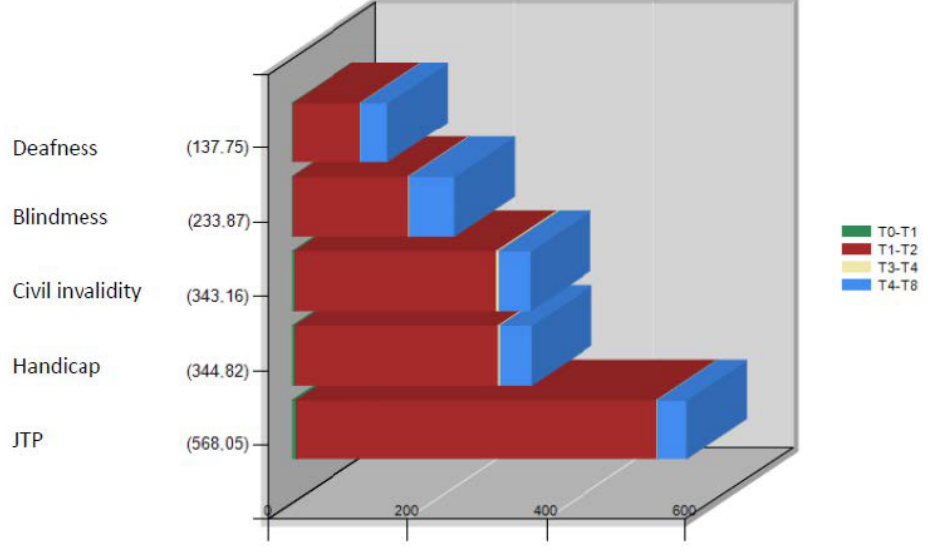
Figure 4. Iglesias: trend of total applications and ASL reports for 2021 (January–September). Figure 5 – Trend in applications processing time (days) 2021 (January-September)